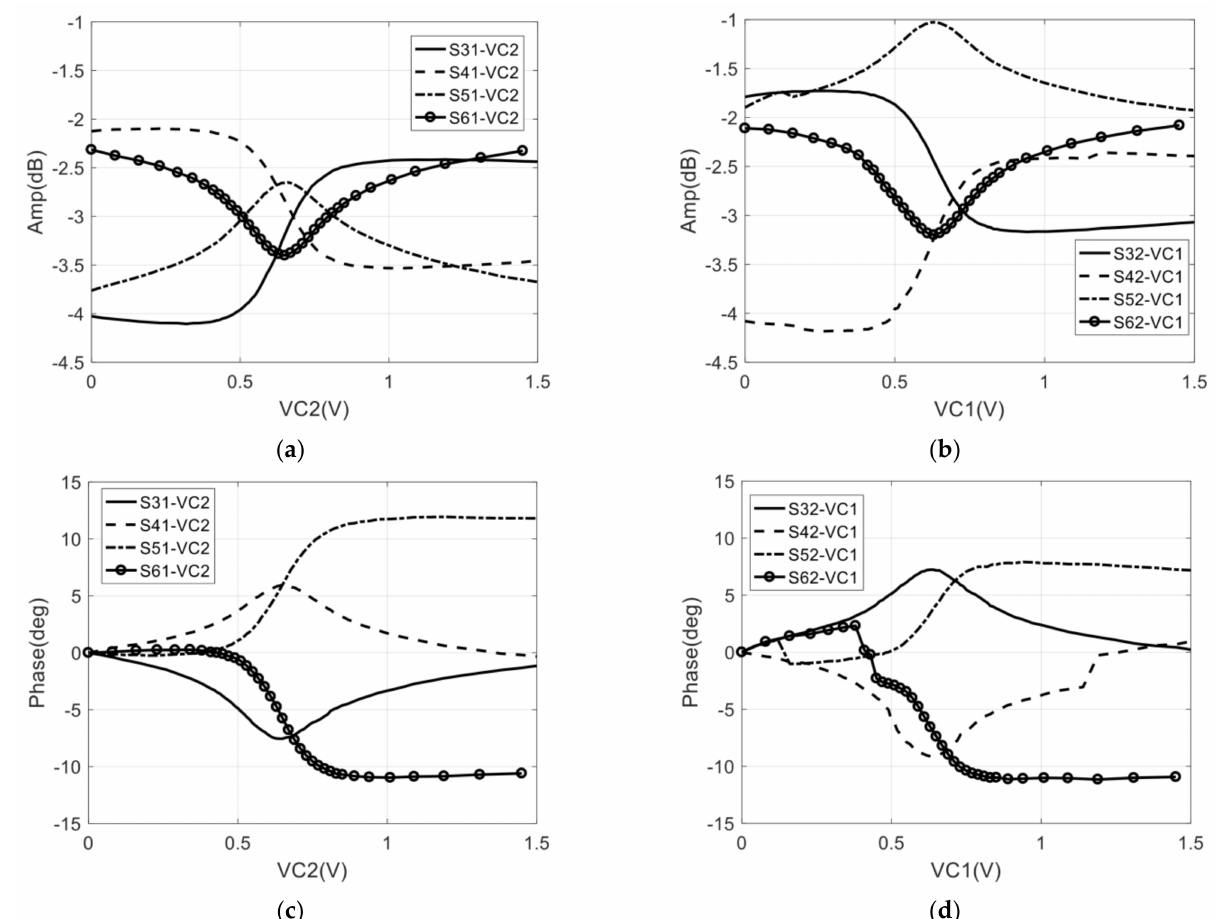
Figure 20. Measurement of the amplitude and phase fluctuation with the change in the control voltage @ 34 GHz: ( a ) Amplitude fluctuation with change of VC2 and input of port 1; ( b ) Amplitude fluctuation with change of VC1 and input of por t2; ( c ) Phase fluctuation with change of VC2 and input of port 1; ( d ) Phase fluctuation with change of VC1 and input of port